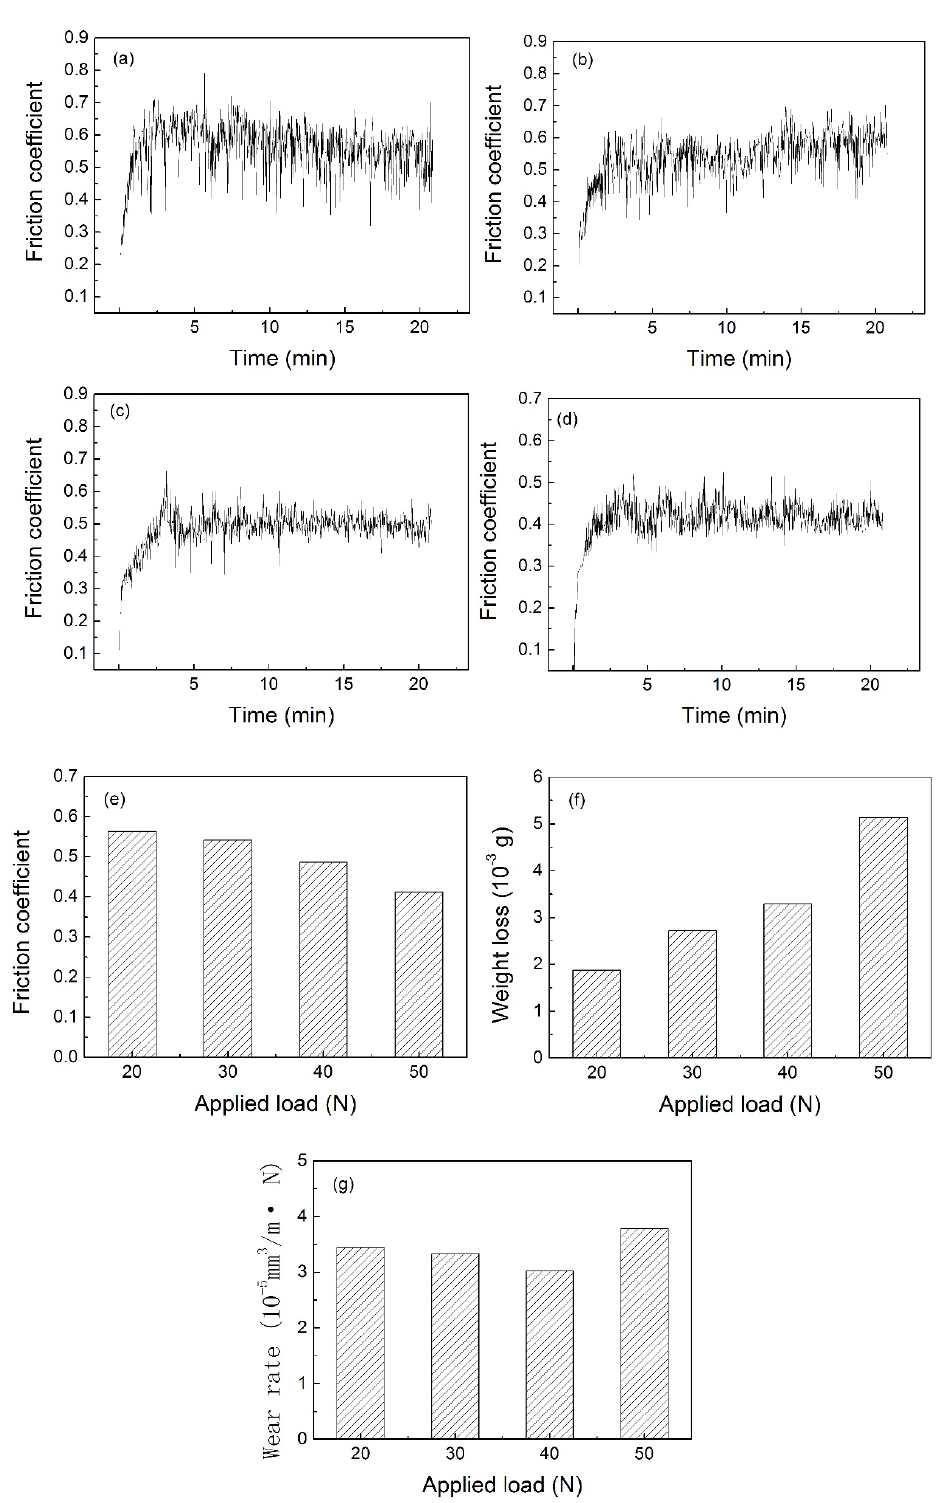
Figure 9. Friction coefficient, weight loss and wear rate of the thixoformed composite parts at different applied load: ( a ) friction coefficient at 20 N, ( b ) friction coefficient at 30 N, ( c ) friction coefficient at 40N, ( d ) friction coefficient at 50N, ( e ) average friction coefficient, ( f ) weight loss and ( g ) wear rate.